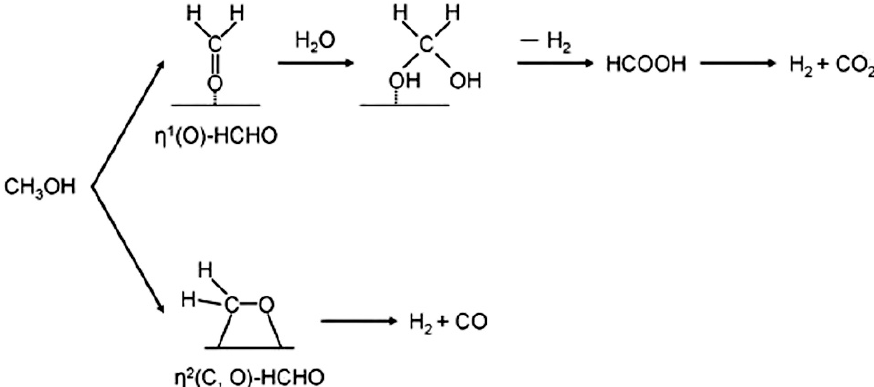
Figure 1. Mechanism of adsorption of methanol molecule over different catalyst surfaces. Reprinted with permission from Ref. [53]. Copyright 2022 Elsevier.